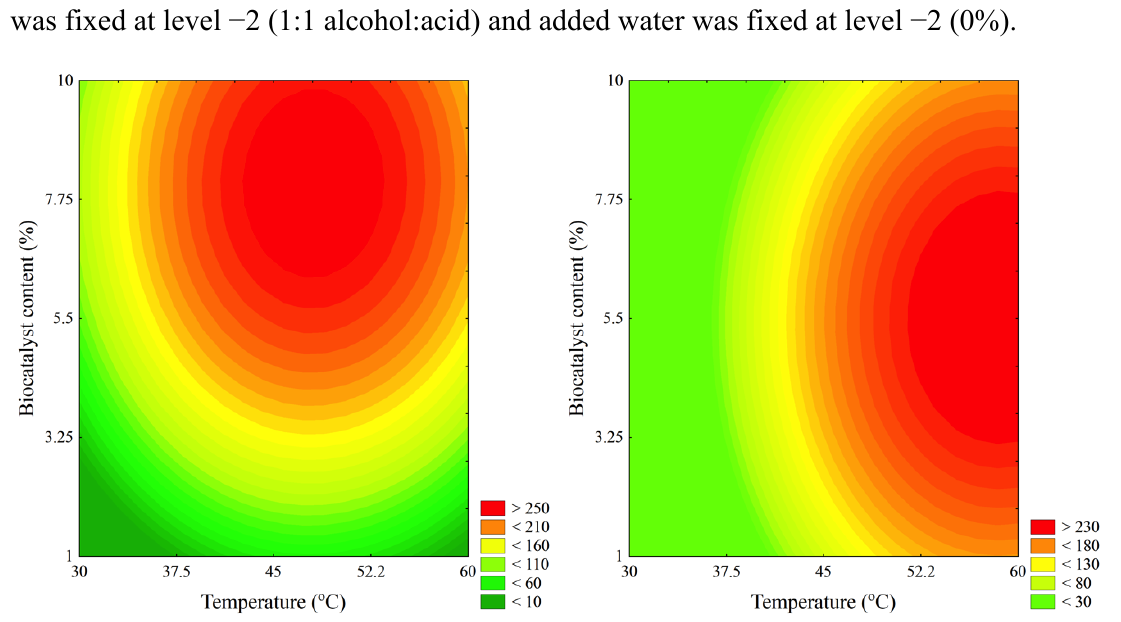
Figure 1. Contour plots for the ultrasound-assisted synthesis of butyl acetate catalyzed by MCI-CALB. ( a ) Condition I: Substrate molar ratio was fixed at level 0.46 (3.46:1 alcohol:acid) and added water was fixed at level − 0.8 (0.28%); ( b ) Condition II: Substrate molar